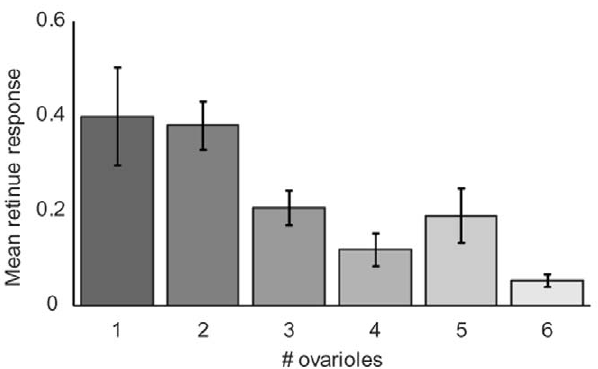
Figure 2. Retinue response is negatively correlated with ovariole number. Ovarioles were dissected and counted from the left, ventral ovary from individual workers from six colonies. A logistic regression demonstrated that there is a strong negative correlation between retinue response and ovariole number (p=0.0014). There was also a significant colony effect (p , 0.0001), but no significant interaction (p=0.11). A bar graph depicts the average retinue response based on the number of ovarioles comprising the left, ventral